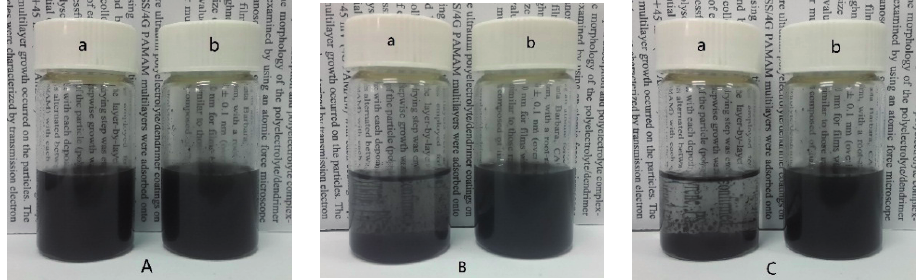
Figure 2. Digital photos of the ethanol deposition of the C-CNTs (a) and pristine CNTs (b) after standing for different times: ( A ) 0 h; ( B ) 6 h; and ( C ) 12